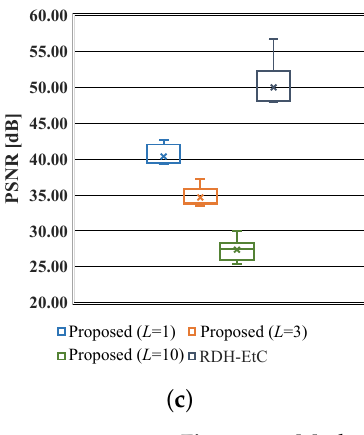
Figure 15. Marked-image quality of proposed and RDH-EtC [30] methods (PSNR). ( a ) Kodim4; ( b ) peppar; ( c ) ihc5 (1/16); ( d ) ihc5 (original).